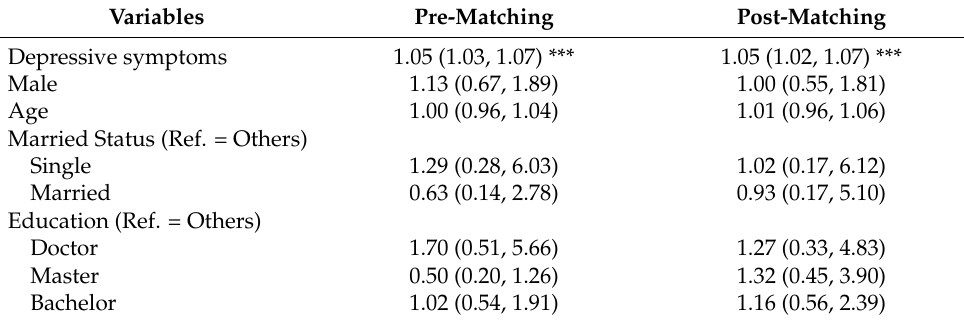
Table 2. Logistic regressions for the association between depressive symptoms and MENM among medical professionals before and after propensity score matching [OR (95%